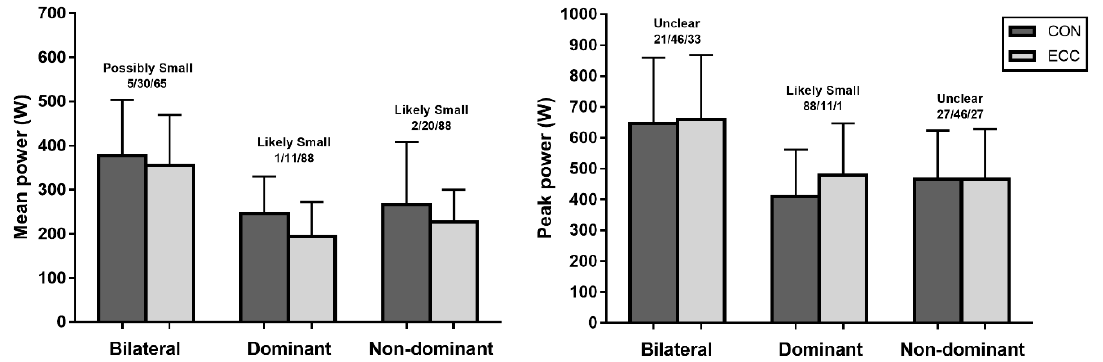
Figure 3. Practical differences in power variables between movement phases.